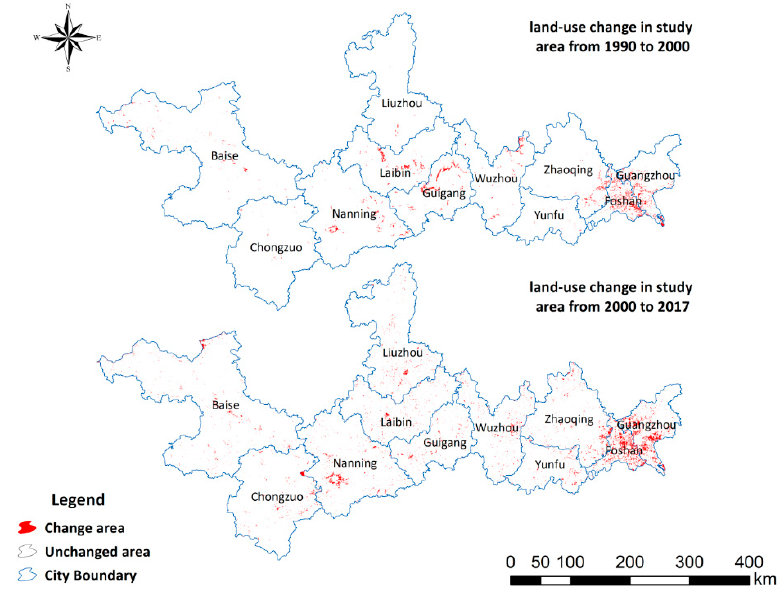
Figure 4. Map of the net change in six land-use types from 1990 to 2000 and 2000 to 2017.